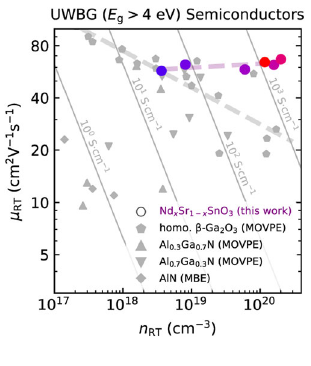
Correction Fig. 1: original fi gure 5